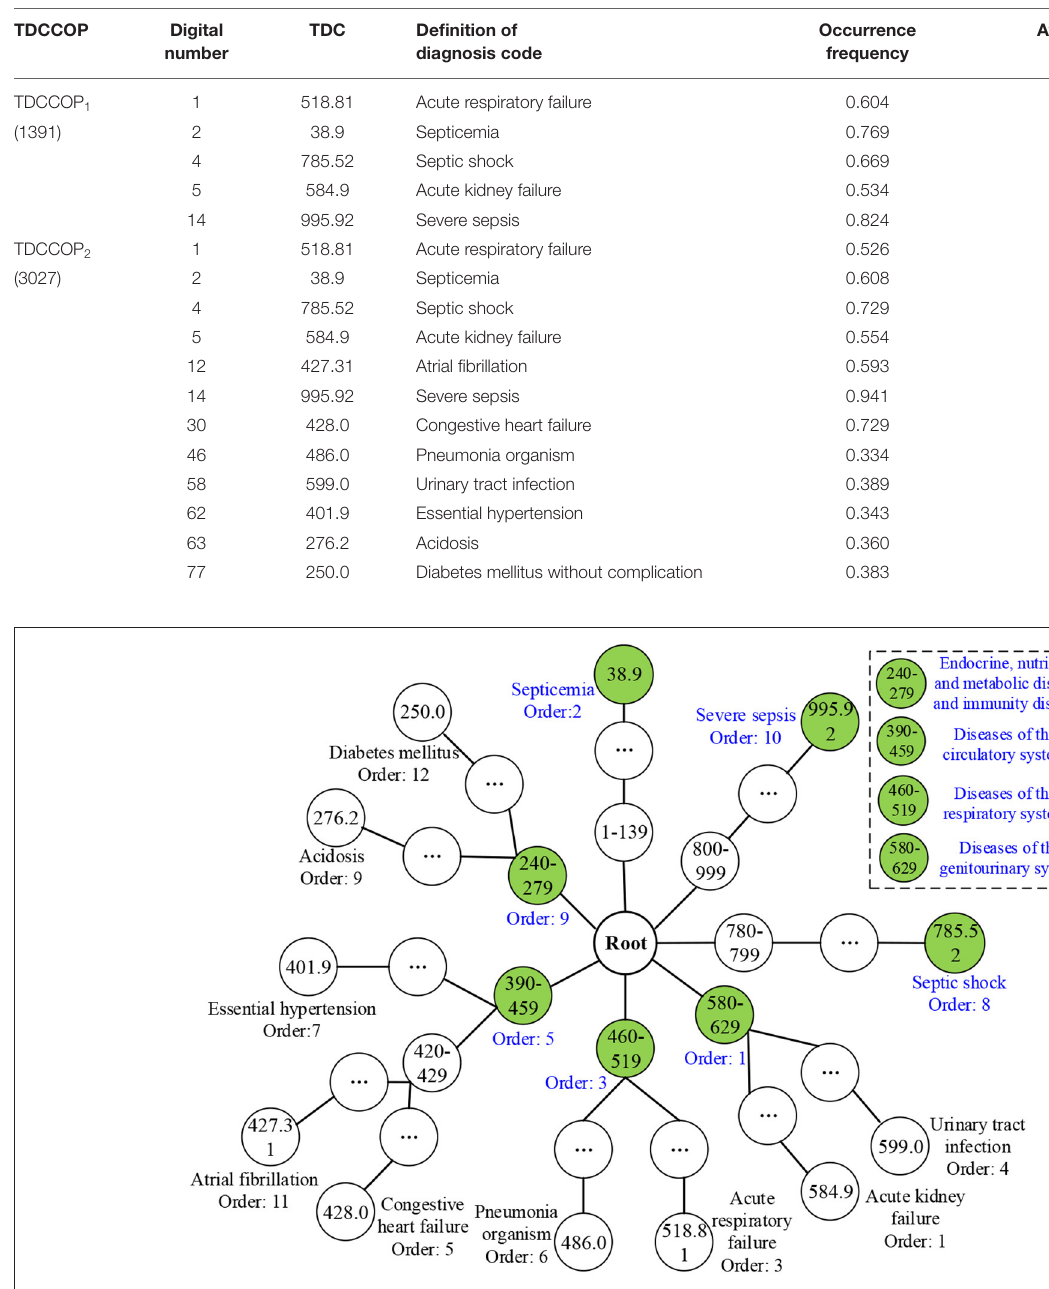
TABLE 2 | Detailed description of three TDC s.